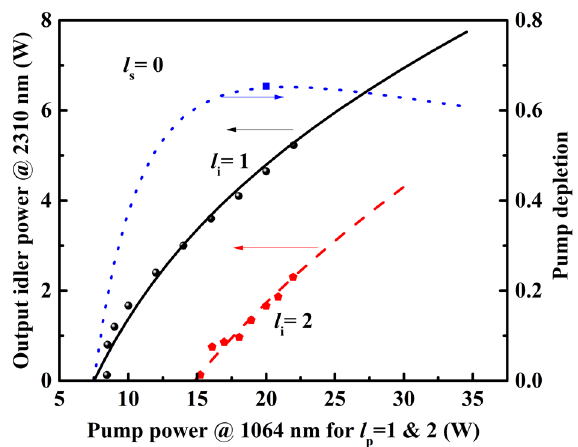
Figure 3. Numerical simulations of output characteristics for SPP-SRO performed by A. Aadhi et al. [24]. Lines are numerical simulations and dots are experimental results.